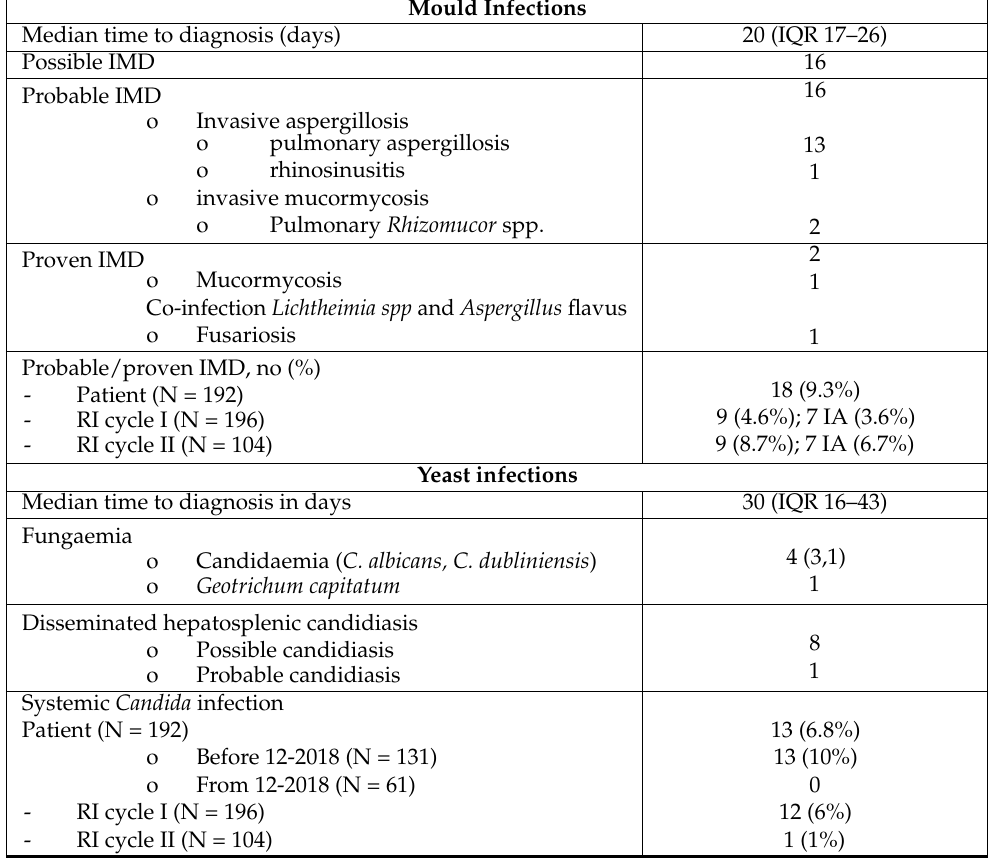
Table 2. Invasive fungal disease (EORTC/MSGERC 2008 and